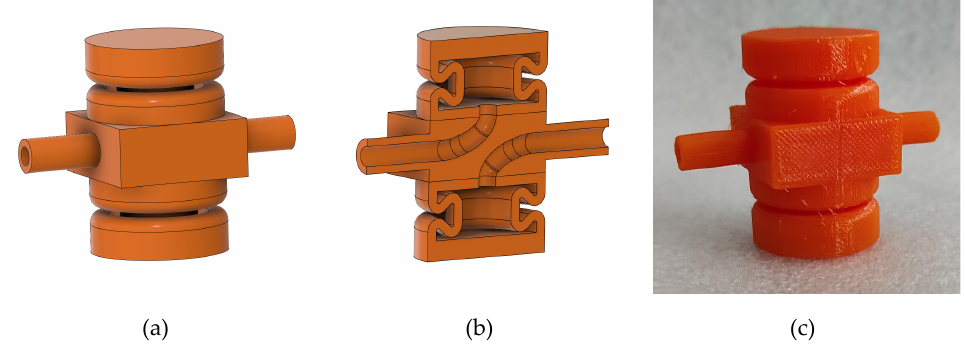
Figure 6. Coupled soft actuators in antagonistic configuration. ( a ) CAD-3D model—CAD software Autodesk Fusion 360. ( b ) Cross-sectional view. ( c ) Photo of the 3D-printed prototype. Table 1. Main 3D printing parameters for the TPU